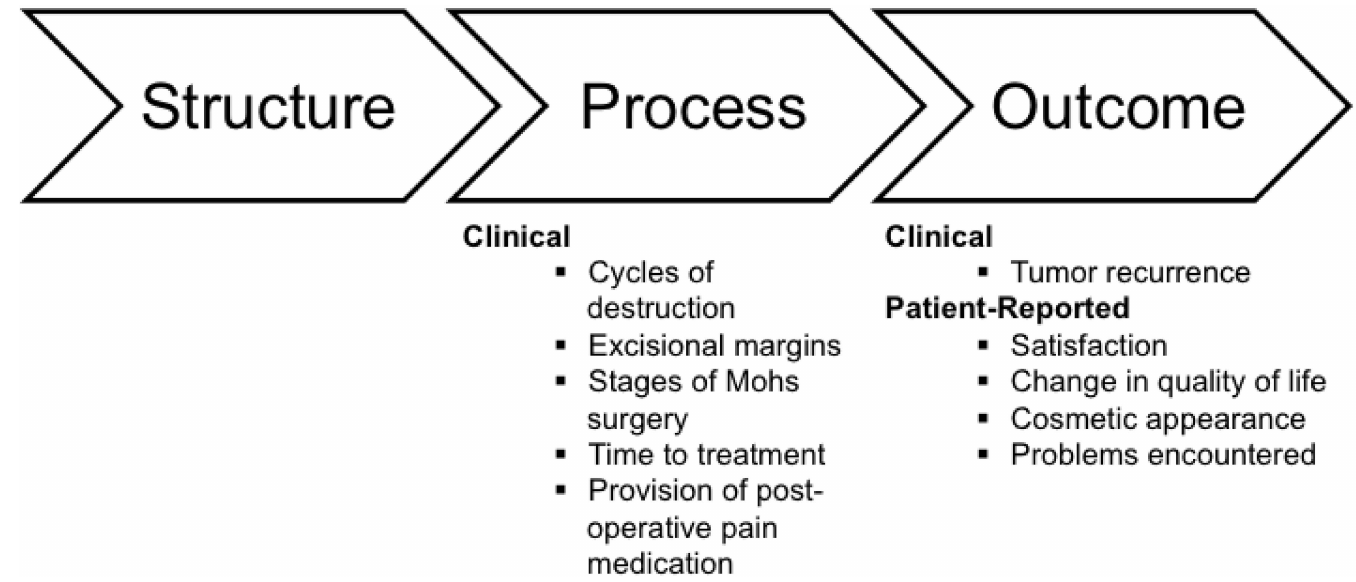
Fig 1. Donabedian Model for quality of care adapted for care of